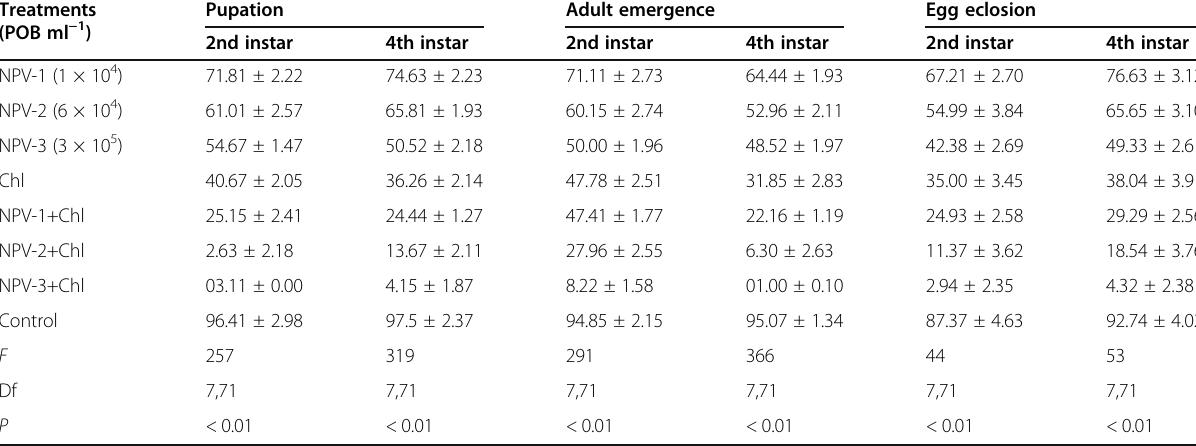
Table 3 The mean pupation, adult emergence, and egg eclosion (% ± SE) of the 2nd and 4th instars ( n = 20) of Spodoptera litura larvae treated with nucleopolyhedrovirus alone and in combination with chlorantraniliprole Treatments (POB ml − 1